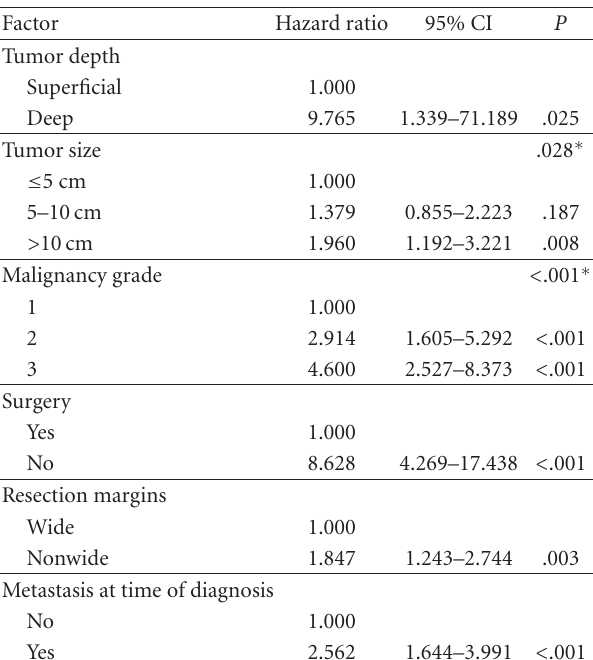
Table 3: Result of the Cox regression analysis among all patients. Table 4: Results of the Cox regression analysis among patients with wide resection margins.